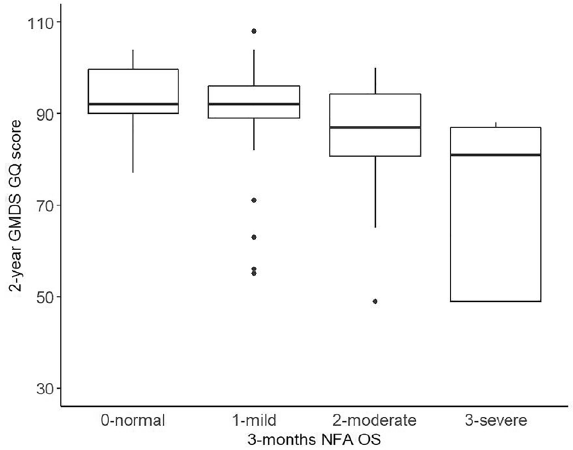
Figure 1. 2-year GMDS global quotient score distribution according to NFA OSs at three months of CA.